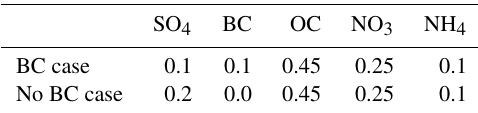
Table 2. Volume fractional composition for BC and no BC simula- tions in all